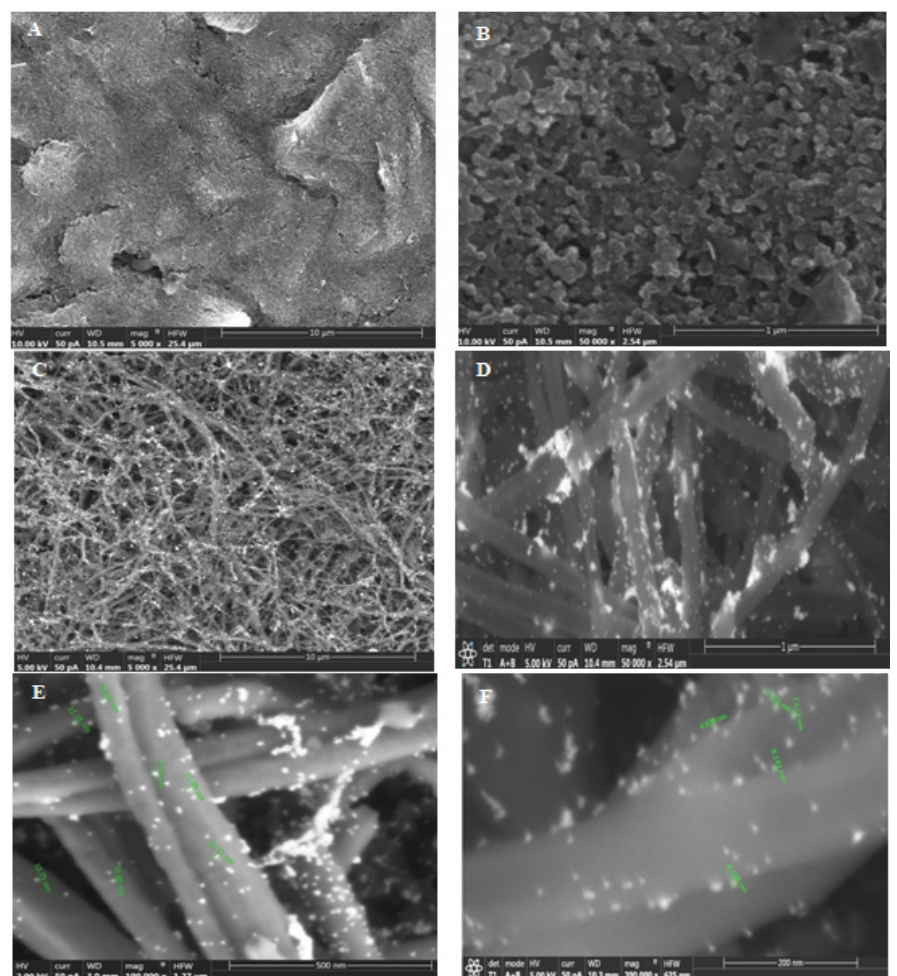
Figure 1. ( A , B ) SEM images of the CSPE and ( C – F ) CSPE/CNFs–AuNPs.